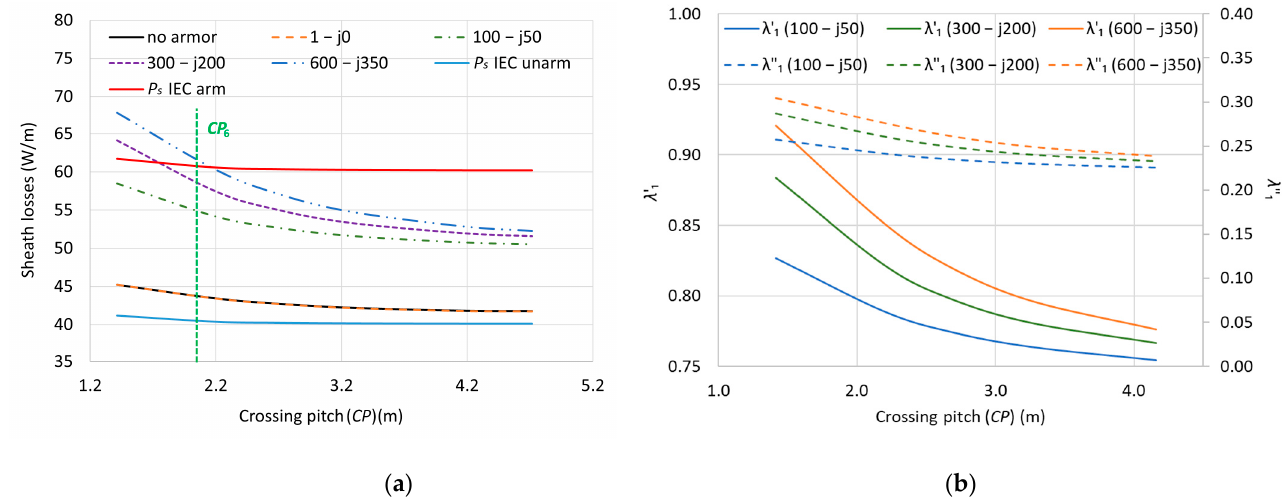
Figure 14. Evolution of ( a ) the total sheath losses and ( b ) the sheath loss factors with CP and the armor permeability in Cable 6 (SB).